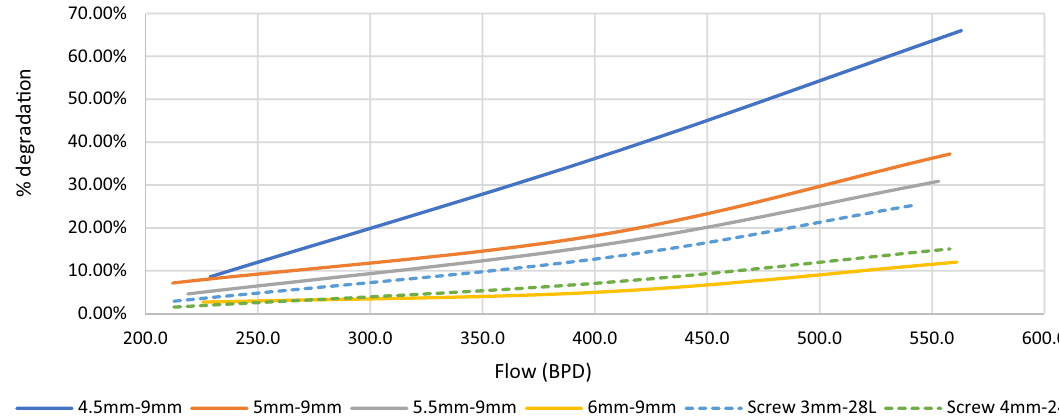
Fig. 4 Pressure drop obtained in the tests of the valve with EOR-500 solution